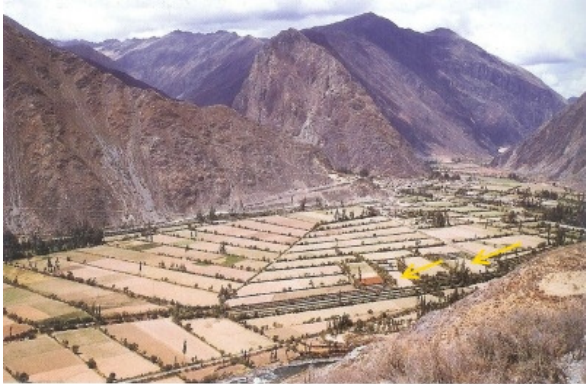
Figure 7: Pyramid with "windows". May be Temple?